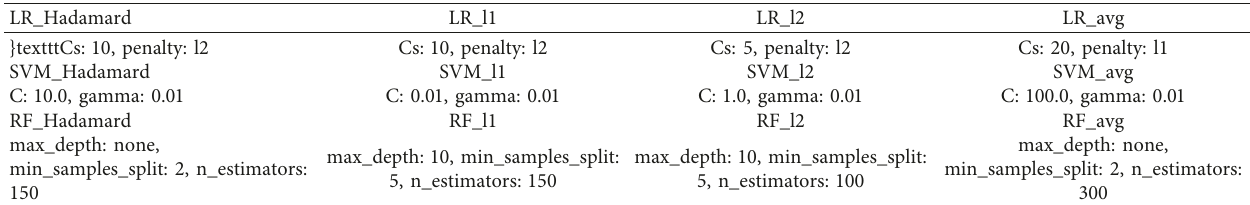
Table 8: For retweeting interaction from May 21 until May 26 in 2021, utilizing the obtained embeddings through Node2Vec, best hyperparameters for LR, SVM, and RF models 1 .